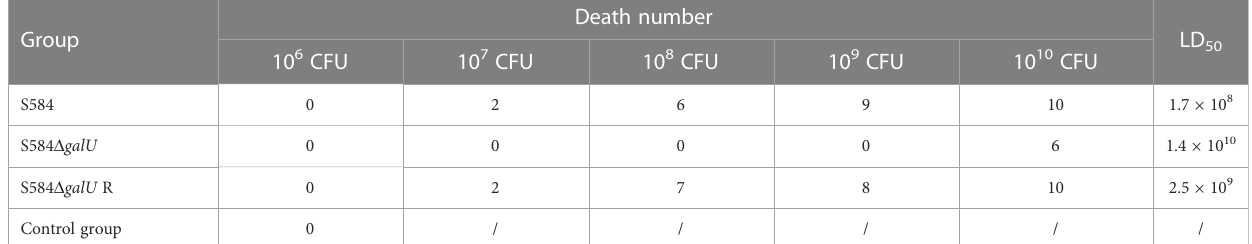
TABLE 3 Virulence analysis of three strains in chicks.